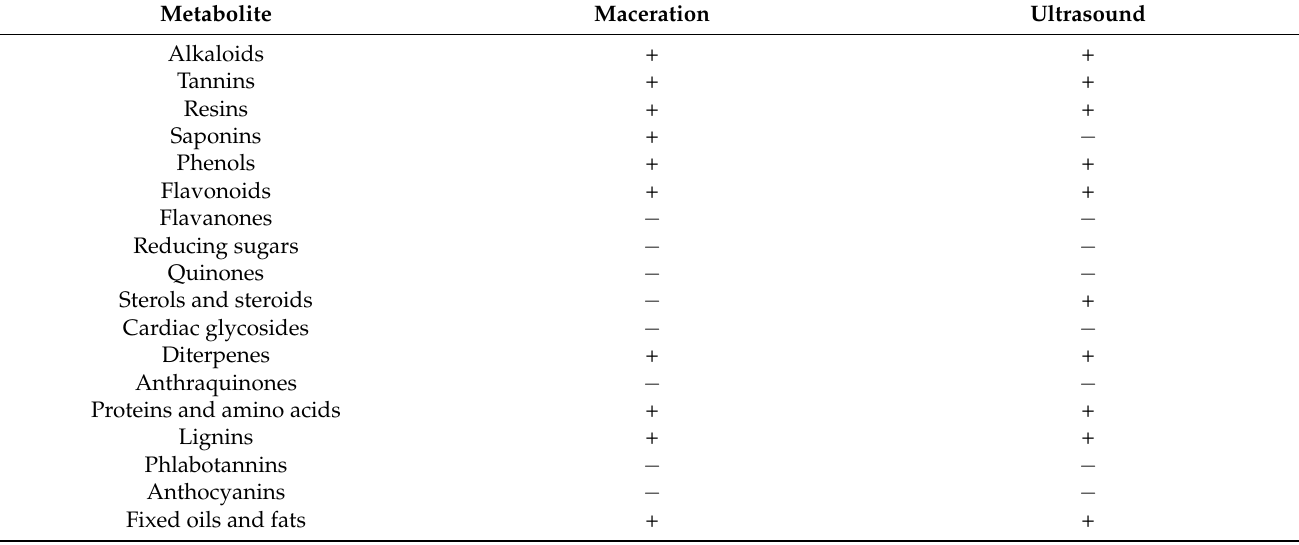
Table 3. Phytochemical screening of P.tetragonolobus extracts with two extraction methods. Metabolite